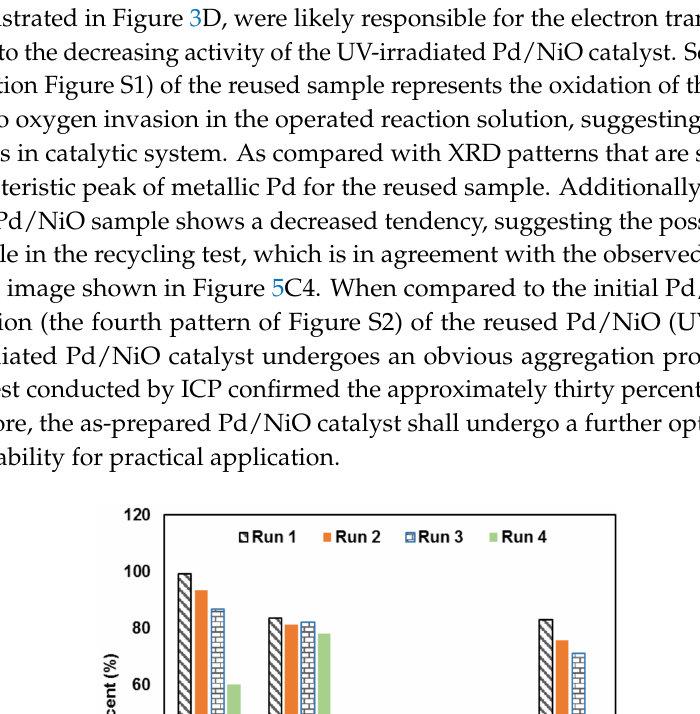
Figure S1: XPS patterns of Pd and Ni elements of as-prepared Pd/NiO catalysts (A) and reused